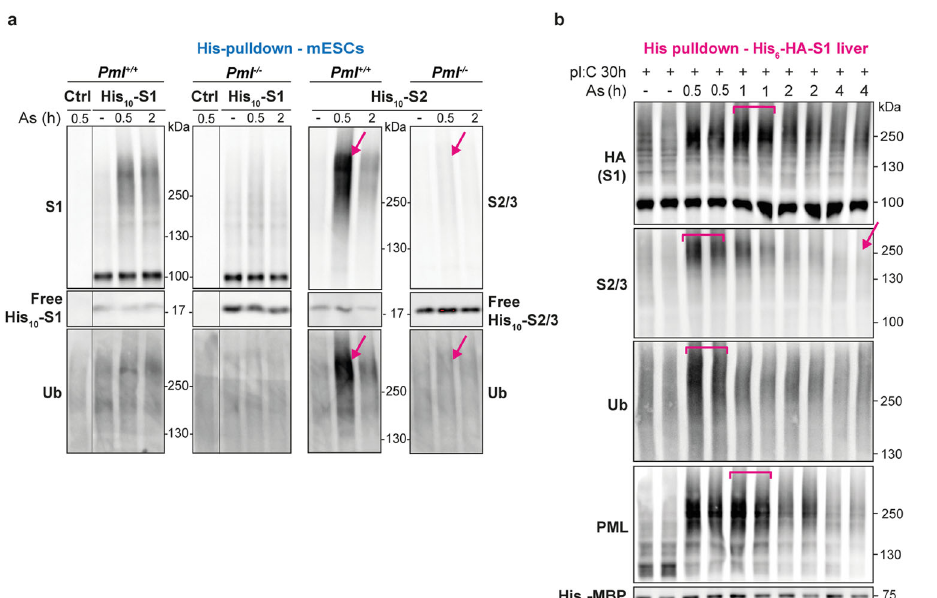
Fig.2|PMLNBsarerequiredforSUMO2/ubiquitinconjugationinvivo.a His-PD ofHis 10 -S1orHis 10 -S2conjugatesfrommESCsexposedtoarsenic,revealingarapid ubiquitination of the SUMO2 conjugates only, after their PML-dependent boost. The levels of the various free His 10 -SUMOs in mESCs are indicated. n =5